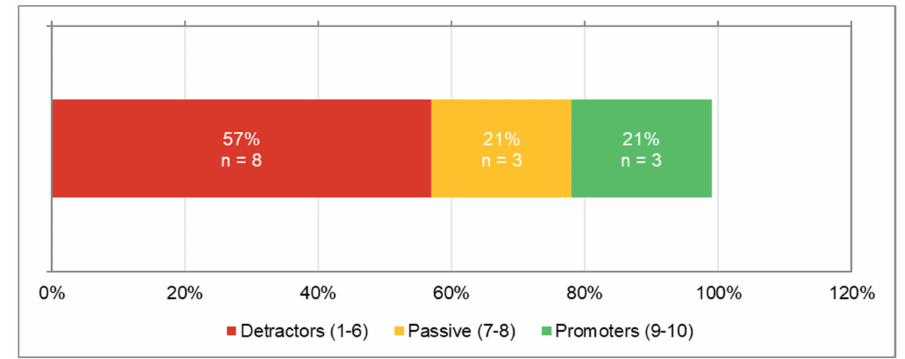
Figure 5. The importance of interoperability among different vehicle categories (e.g., buses and trucks).